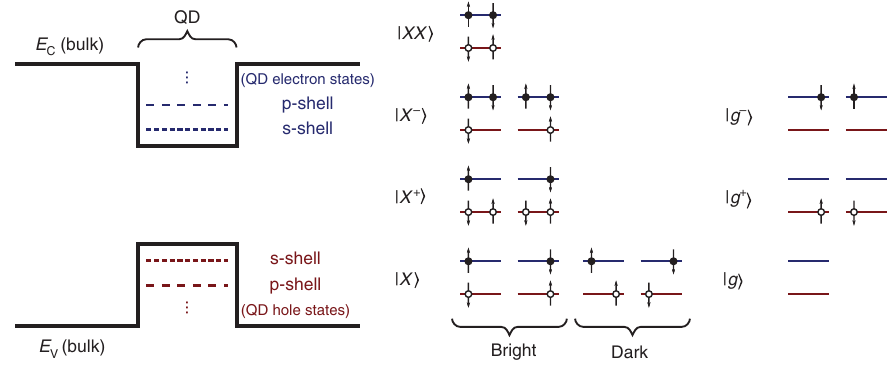
Figure 2: QD states. Schematic energy band diagram (conduction band E and valence band E ) for a QD embedded in a bulk host semiconductor (left) with C V possible exciton configurations (exciton | X ⟩, charged excitons | X ± ⟩, and biexciton | XX ⟩) of the s-shell discrete energy levels (middle) and ground states (charged | g ± ⟩ and neutral | g ⟩) corresponding to recombination of the excitons (right). Filled and empty circles represent electrons in conduction band and holes in valence band, respectively. Arrows represent the spin state (up or